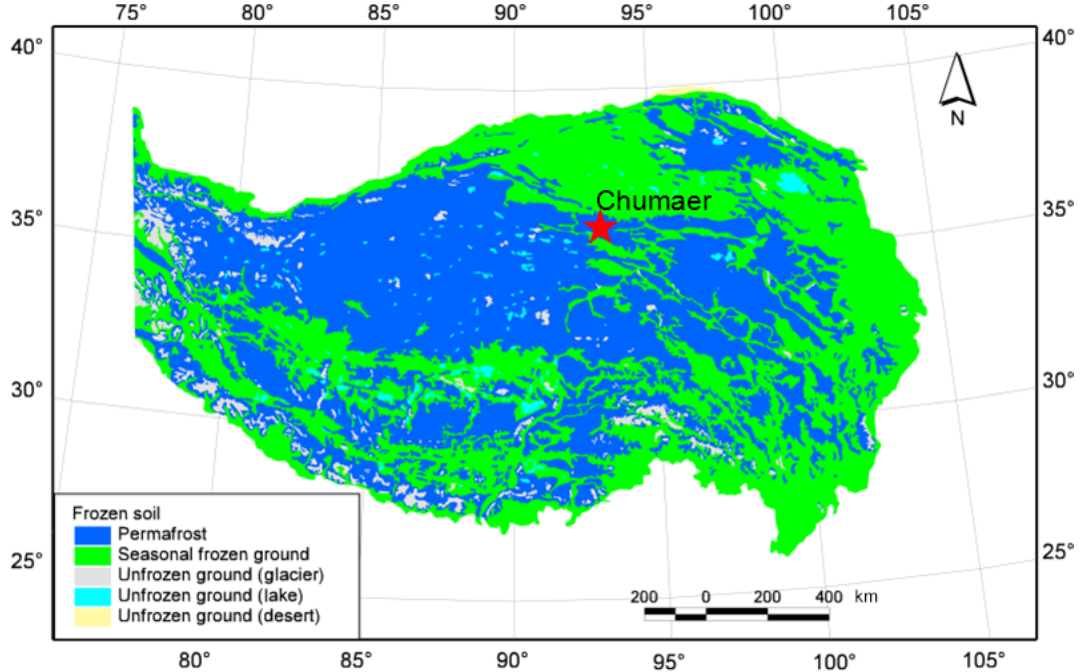
Figure 1. Study site location and permafrost distribution on the Qinghai–Tibet Plateau. The background map shows the permafrost classes from Li and Cheng